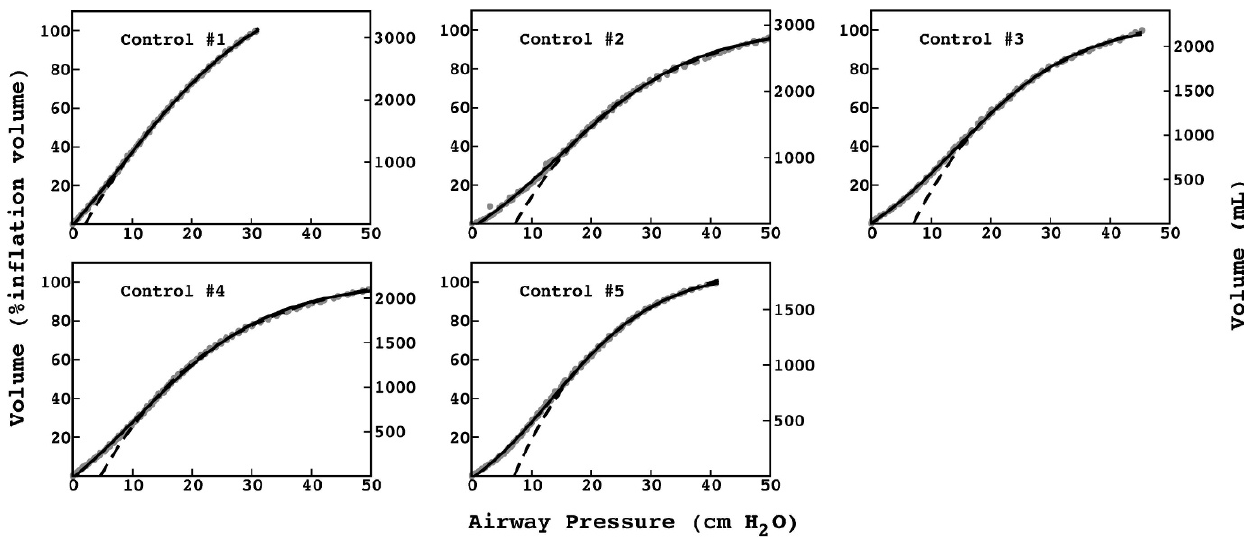
Figure 3 - PV curves from the controls. The data points (gray circles) were fit to an exponential (dashed line) and a sigmoidal equation (solid line). The exponential equation yielded an adjusted R 2 = 0.9853 ¡ 0.01, and the sigmoidal equation yielded an adjusted R 2 =0.9996